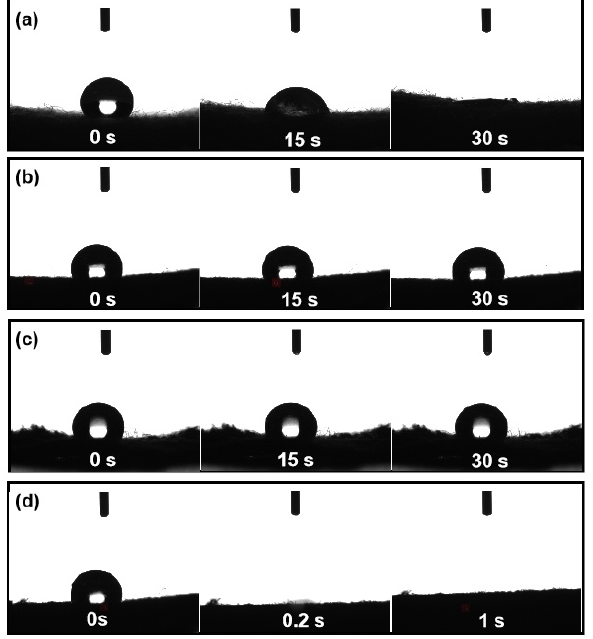
Figure 8. Water contact angle test images of CFs ( a ), PPy@CFs ( b ), PB@CFs ( c ), and PB/PPy@CFs ( d ).